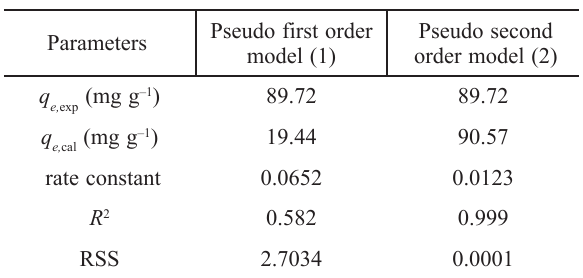
Table 2 – Pseudo first order and pseudo second order kinet- ics model parameters for adsorption of HA using